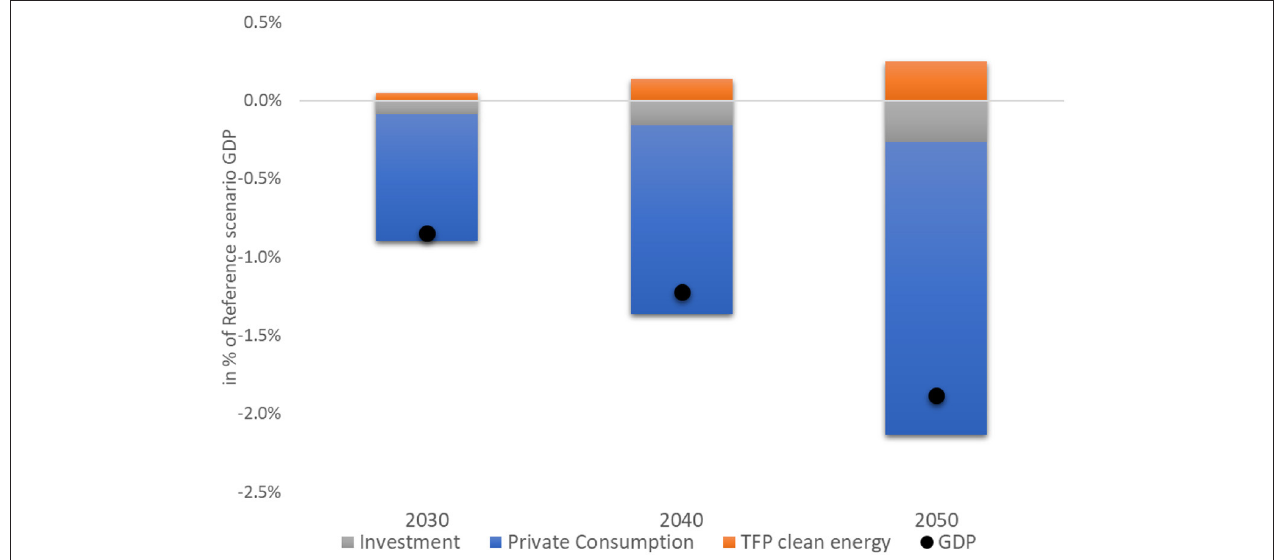
FIGURE 12 | Decomposition of global GDP changes in 2DEG relative to Reference for 2030 and 2050. The contribution of each component reflects its change from Reference levels expressed as a share of GDP in 2030 and